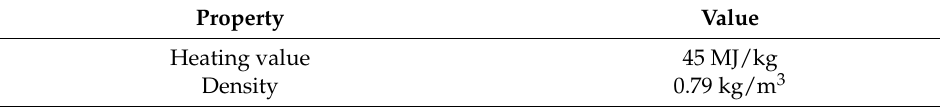
Table A3. Natural gas parameters